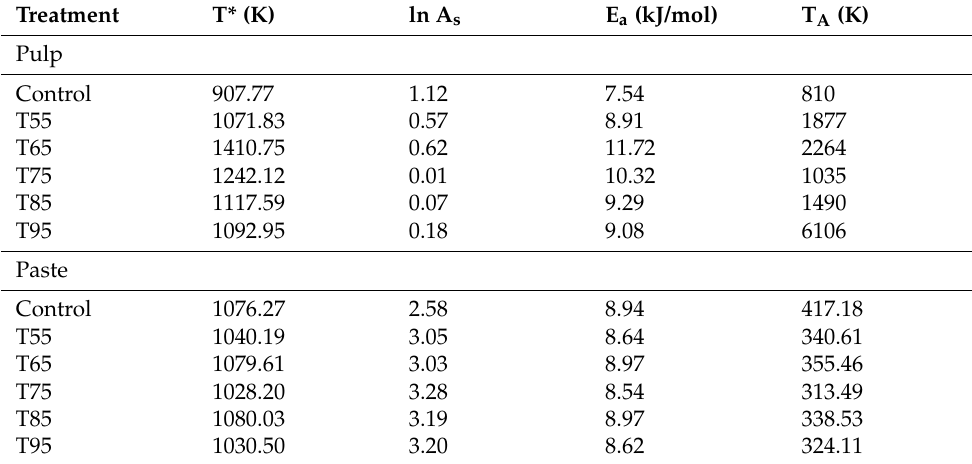
Table 3. Arrhenius parameters for temperature-dependent apparent viscosity of currant tomato pulp and paste 1 .